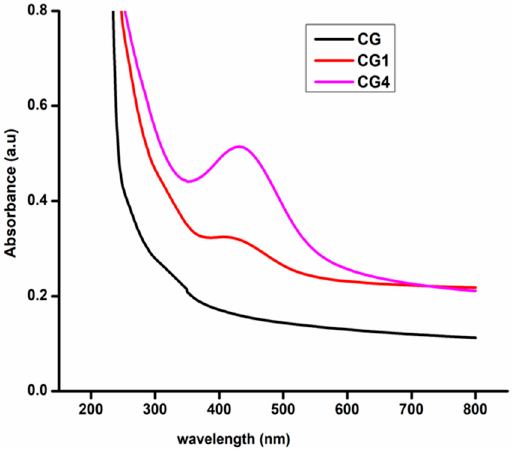
Figure 8. UV–Visible spectra of the synthesized nanocomposite films.